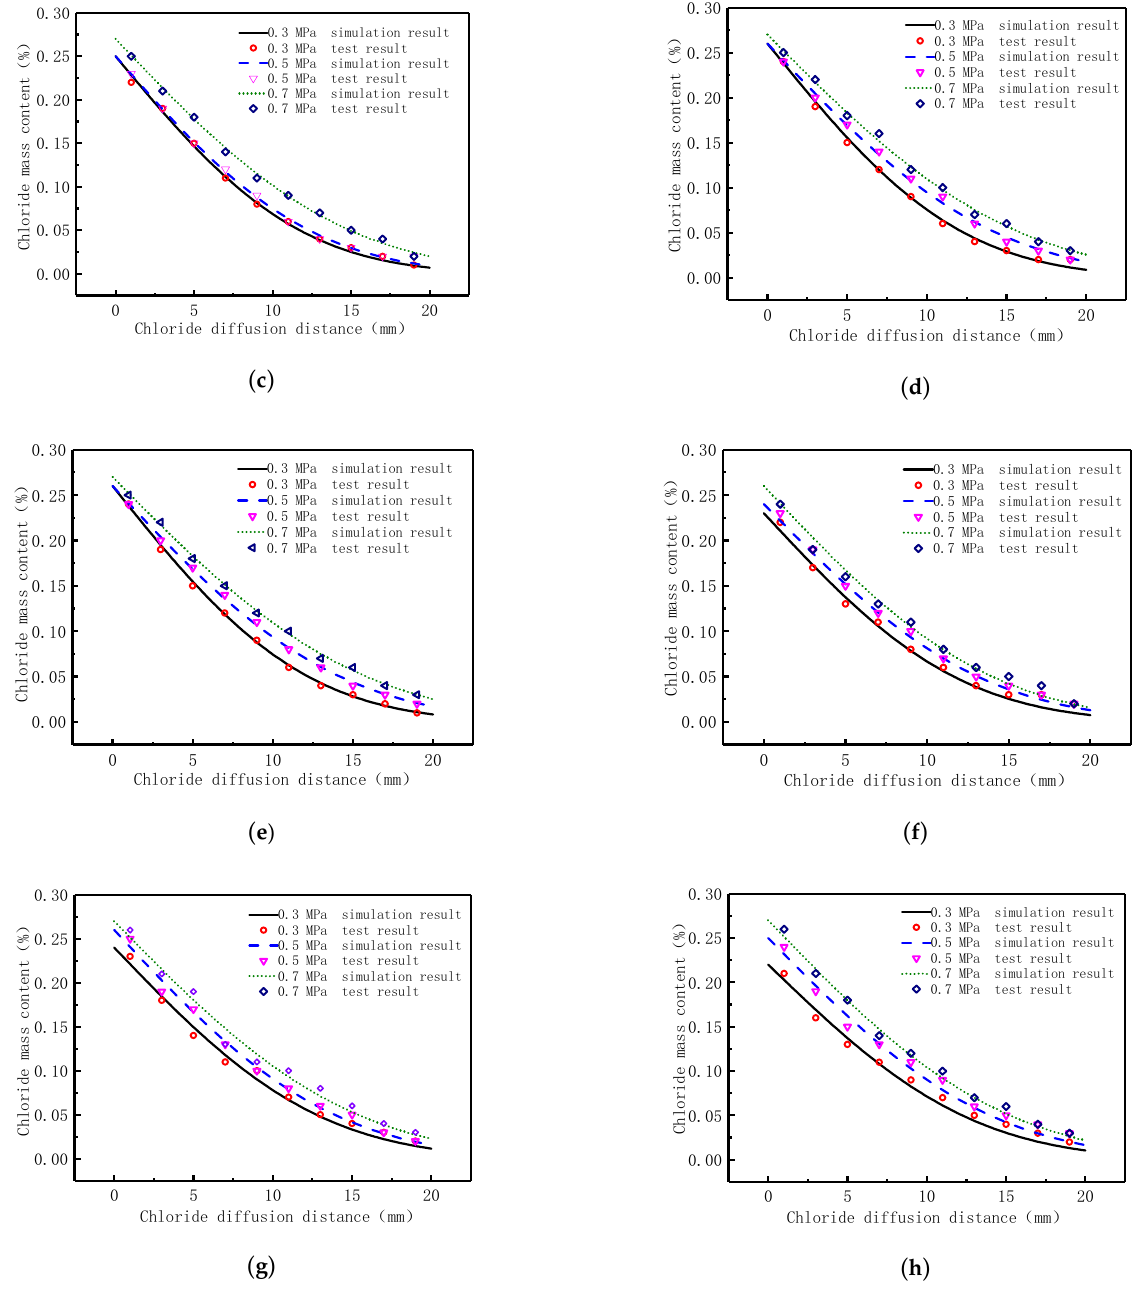
Figure 3. The simulation and test results on diffusion behavior of chloride in pressurized diffusion source solutions. ( a ) 3.5% NaCl diffusion source solution; ( b ) 0.5 M NaCl diffusion source solution; ( c ) 0.5 M KCl diffusion source solution; ( d ) 0.25 M CaCl 2 diffusion source solution; ( e ) 0.25 M MgCl 2 diffusion source solution; ( f ) 0.25 M NaCl + 0.25 M KCl diffusion source solution; ( g ) 0.25 M NaCl + 0.125 M CaCl 2 diffusion source solution; ( h ) 0.125 M MgCl 2 + 0.125 M CaCl 2 diffusion source solution.